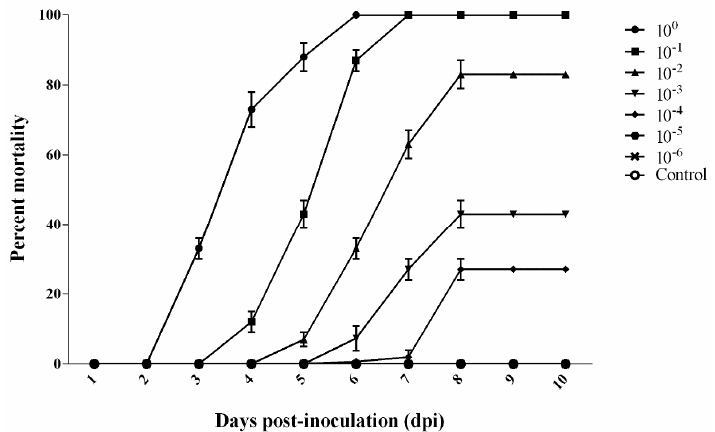
Figure 6. Cumulative mortality curves for the determination of LD 50 in M. rosenbergii challenged with C. freundii at different concentrations.